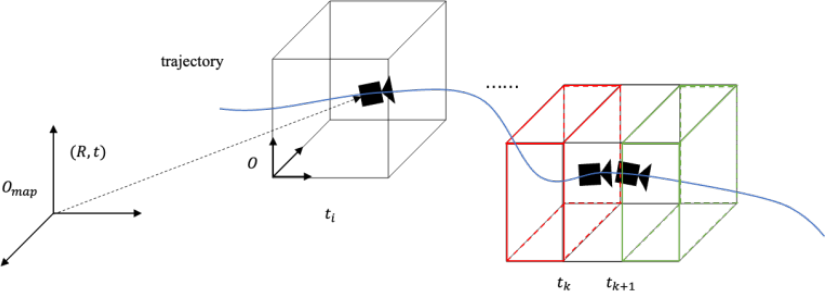
Figure 2. Sliding grid map model. The model is made of regular voxels, with the map origin in the lower right corner and the MAV in the center of the map, as shown at t i . The map origin is adjusted with MAV movement, and the unnecessary part (red area) is cleared. Thanks to the mapping relationship of the array index, the newly observed area (green area) is set, as shown from t k to t k + 1 . To obtain the occupancy information of a point p W , firstly calculate the voxel coordi- nate of p W